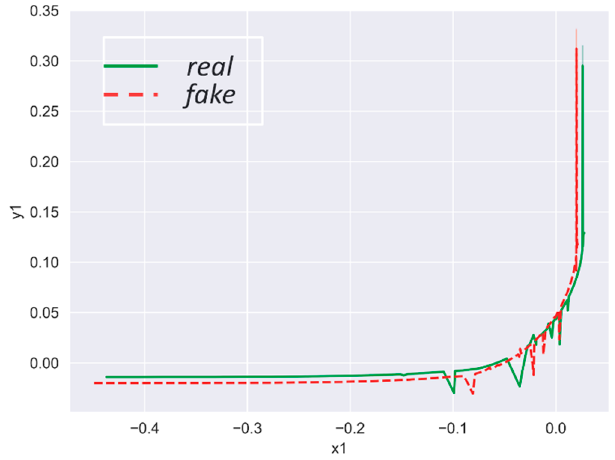
Figure 7. The real and generated trajectories of ego-vehicles in intersection environments; (x1, y1) are the coordinates of the ego-vehicle.